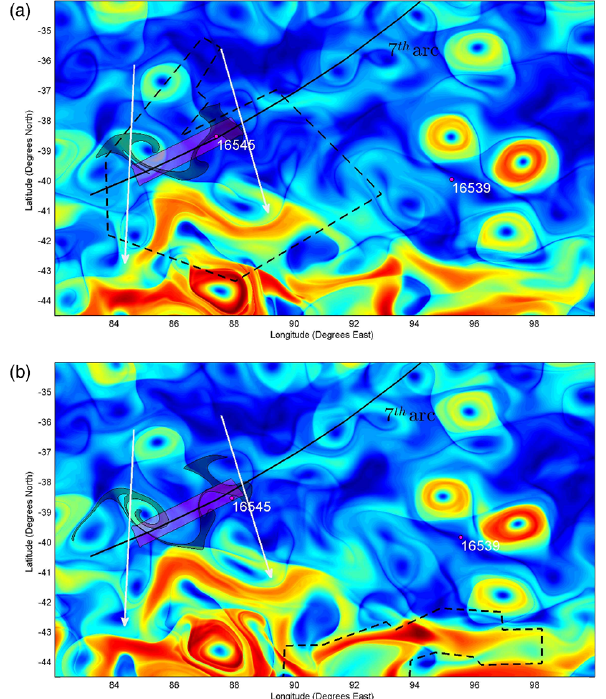
Figure 2. A summary of the debris search for the Malaysian MH370 plane in the southern Indian Ocean. In the background the M function, evaluated on AVISO data for τ = 20 days, high- lights mesoscale structures and invariant manifolds. Overlapped are the drifters in the area (magenta dots), the expected flight paths (white arrows), the likely impact area (pink) and its contour evolu- tion (gray). Dashed lines outline the search areas for the respective dates, (a) 19 March 2014 and (b) 27 March 2014.